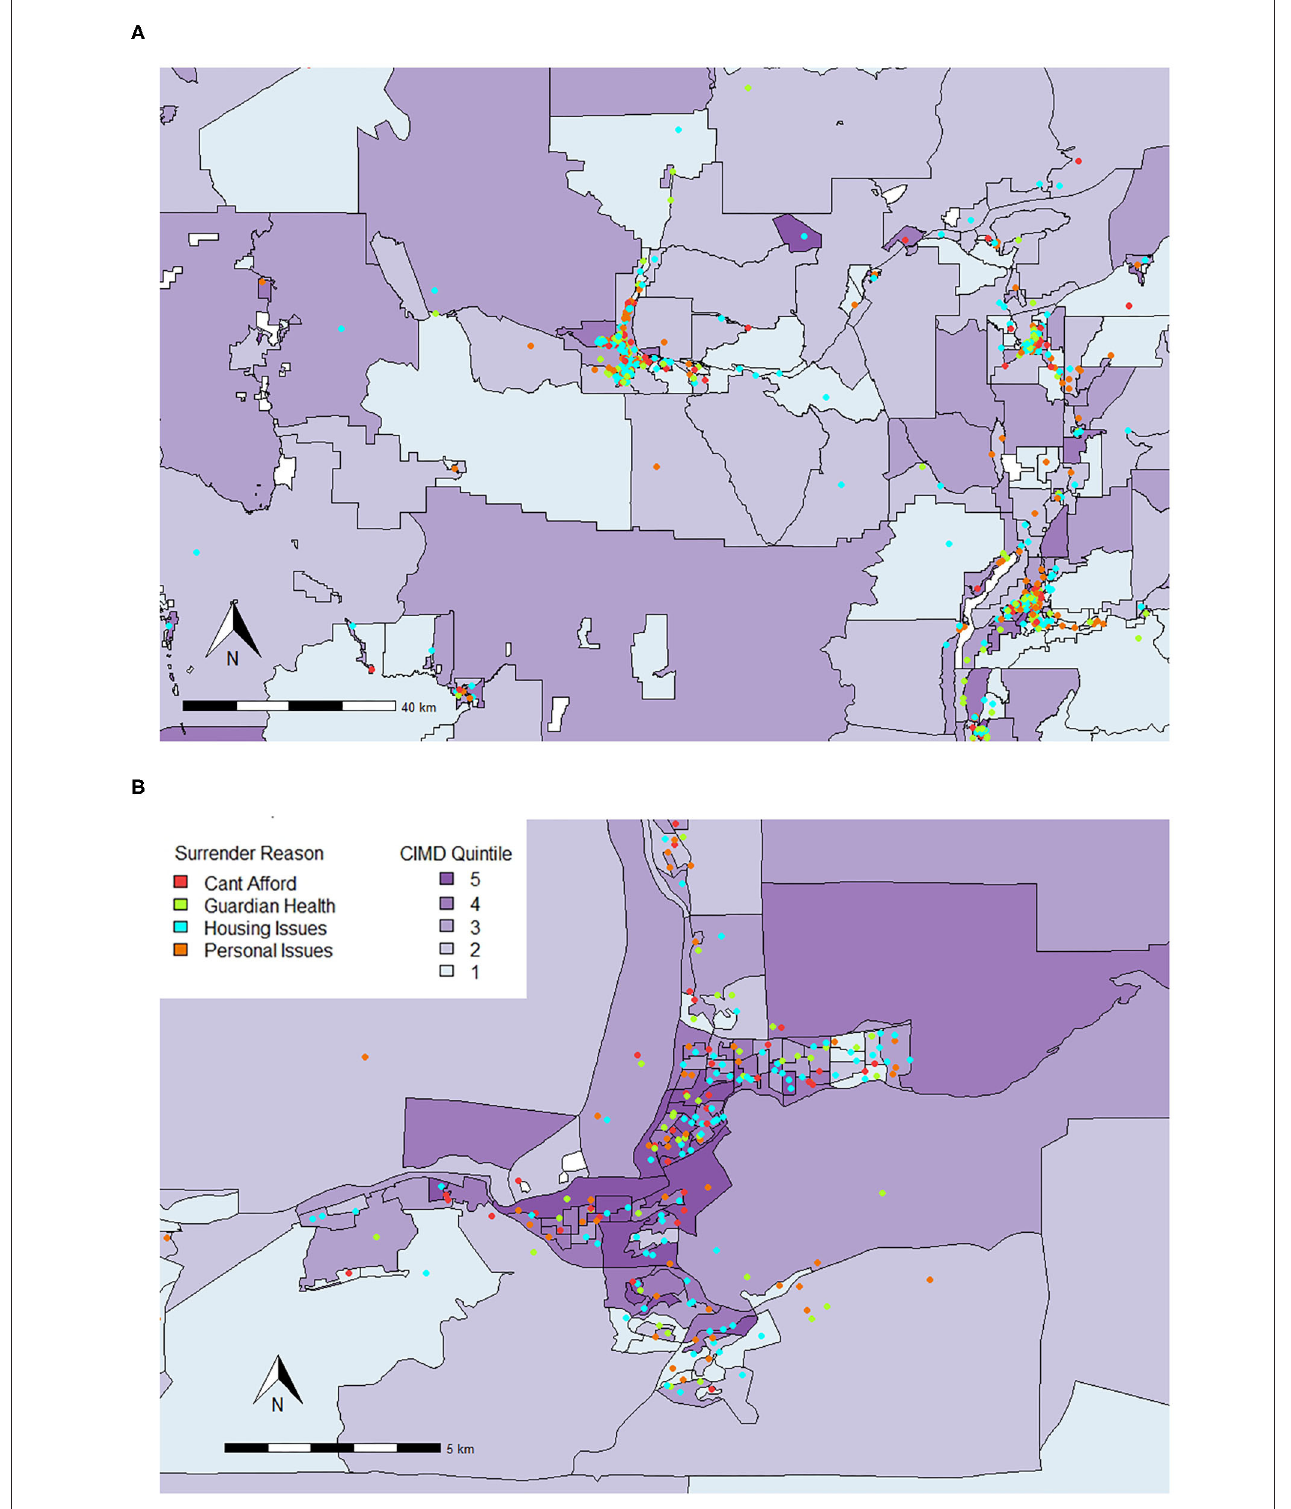
FIGURE 7 | Locations where animals were surrendered for various owner-related reasons for surrender in (A) Kamloops and the surrounding area and (B) the City of Kamloops (September 1, 2016 to August 31, 2020) plotted on top of quintiles for Residential Instability (1 = least instable, 5 = most instable). The Residential Instability factor of the CIMD includes indicators such as the proportion of apartment dwellings; the proportion of persons living alone; the proportion of rented dwellings; and the proportion of population that has moved in the last 5 years. While each point shows the dissemination area of origin, it does not represent the true address.